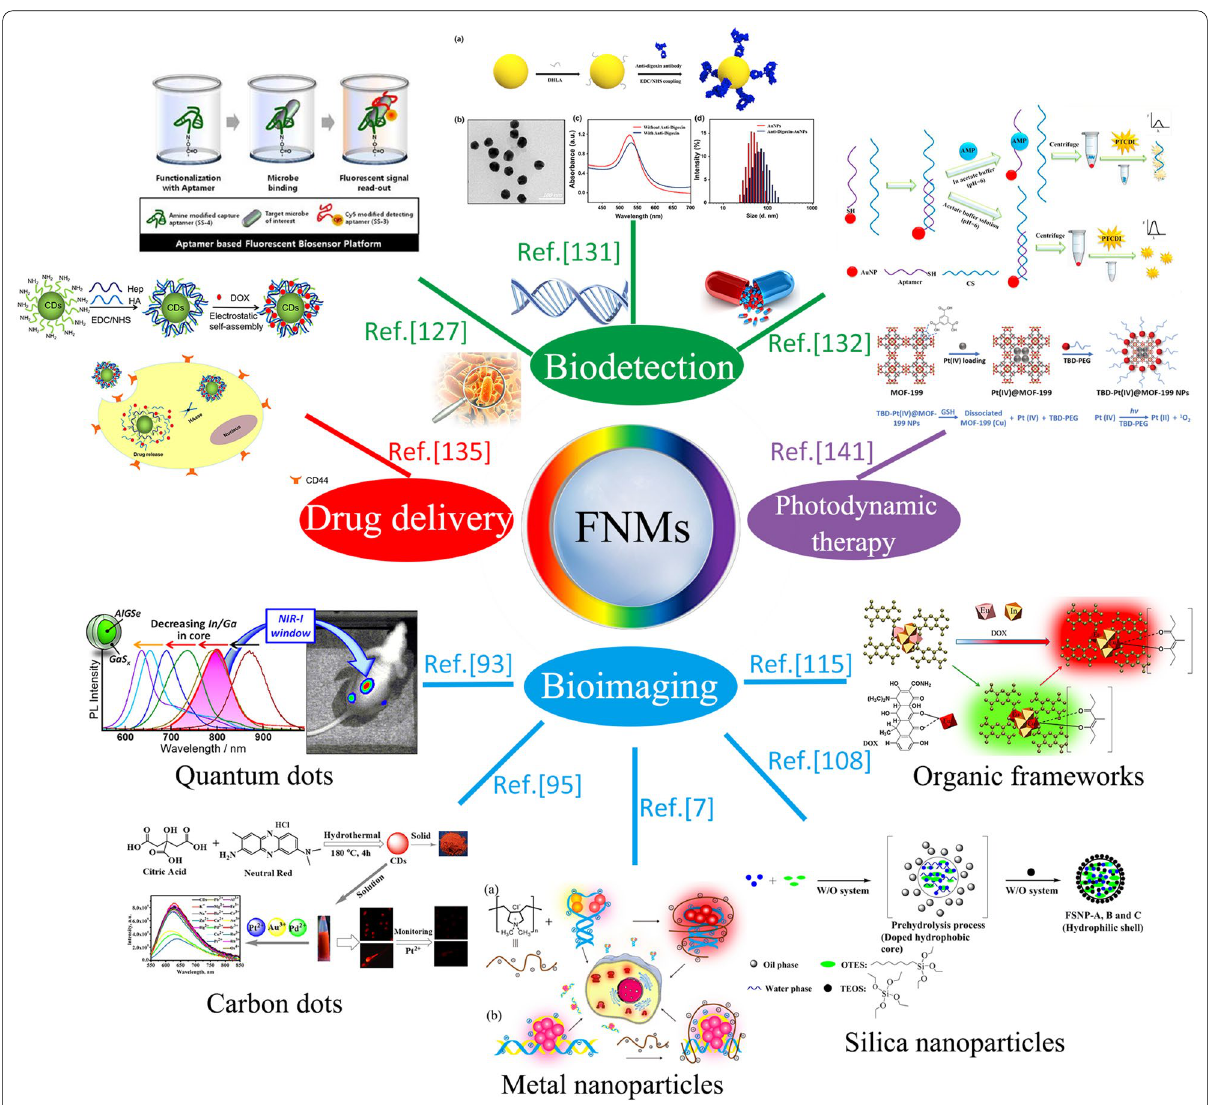
Fig. 1 The overview diagram of biomedical applications of fluorescent